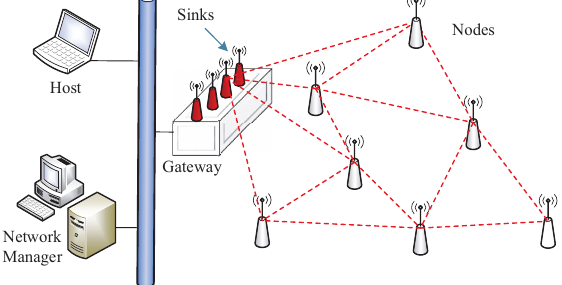
Figure 1. The structure of an industrial wireless sensor-actuator network (WSAN) system.